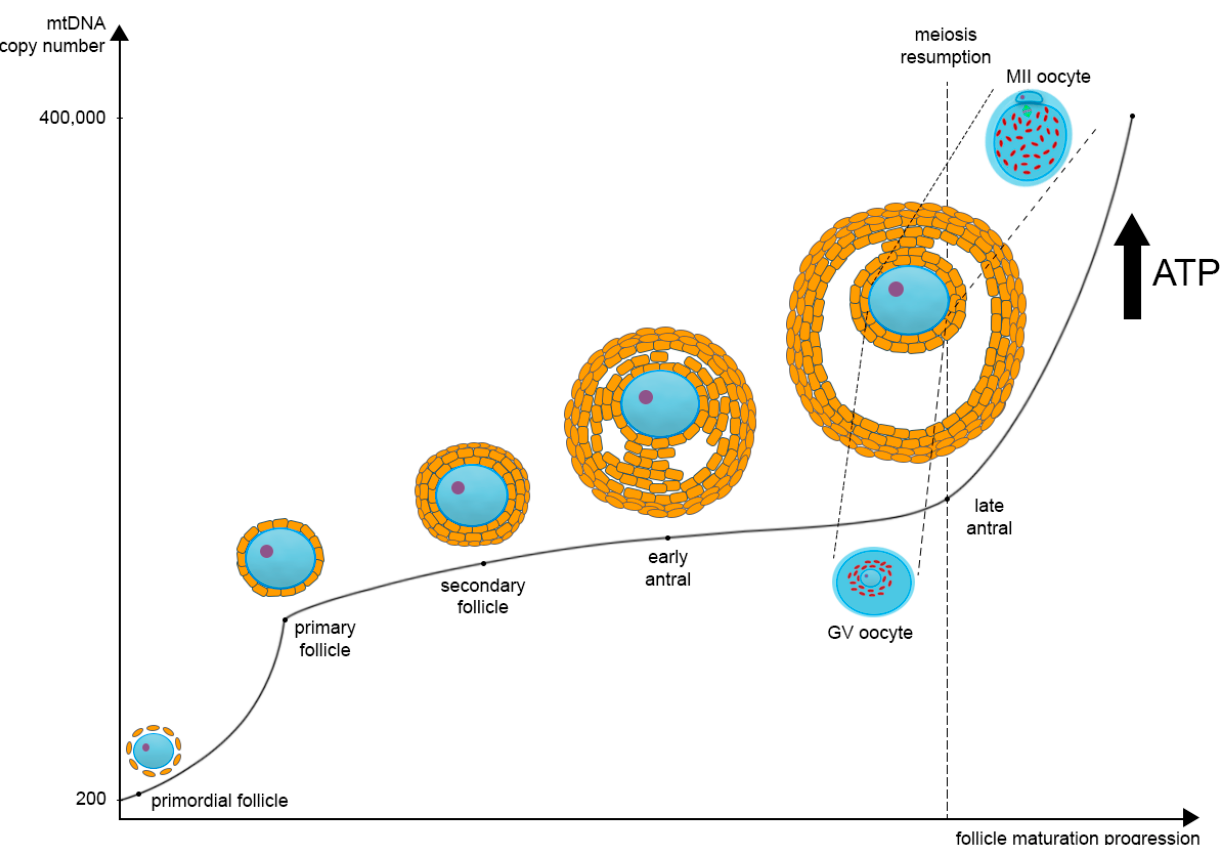
Figure 1. The regulation of mitochondrial DNA (mtDNA) copy number and mitochondria distribution during oocyte maturation. In primordial germ cells, the amount of mtDNA is very low. As oogenesis progresses, mtDNA copies increase significantly and then reach their maximum at the MII stage. There are two main points at which mtDNA copies go up very quickly: the first one is during the transition from the primordial to the primary follicle stage, and the second one is during the transition from GV to MII oocytes at the late antral follicle stage. In parallel as oogenesis progresses, ATP level also increases significantly as oocyte maturation requires a large amount of ATP for the subsequent transcription and translation. During the transition from GV to MII oocytes at the late antral follicle stage, the distribution of mitochondria changes significantly. They migrate from the center of the ooplasm to the pericortical region, distributing evenly through the whole ooplasm.